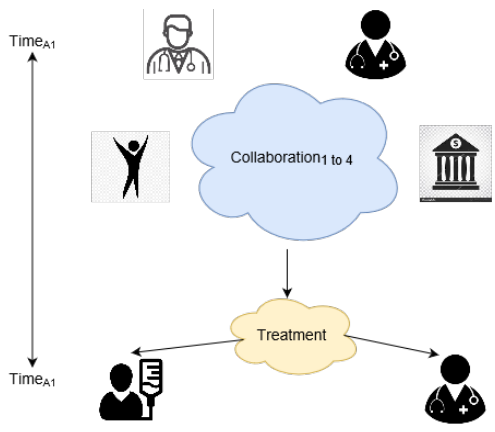
Figure 3. Proposed collaborative medical decision-making.